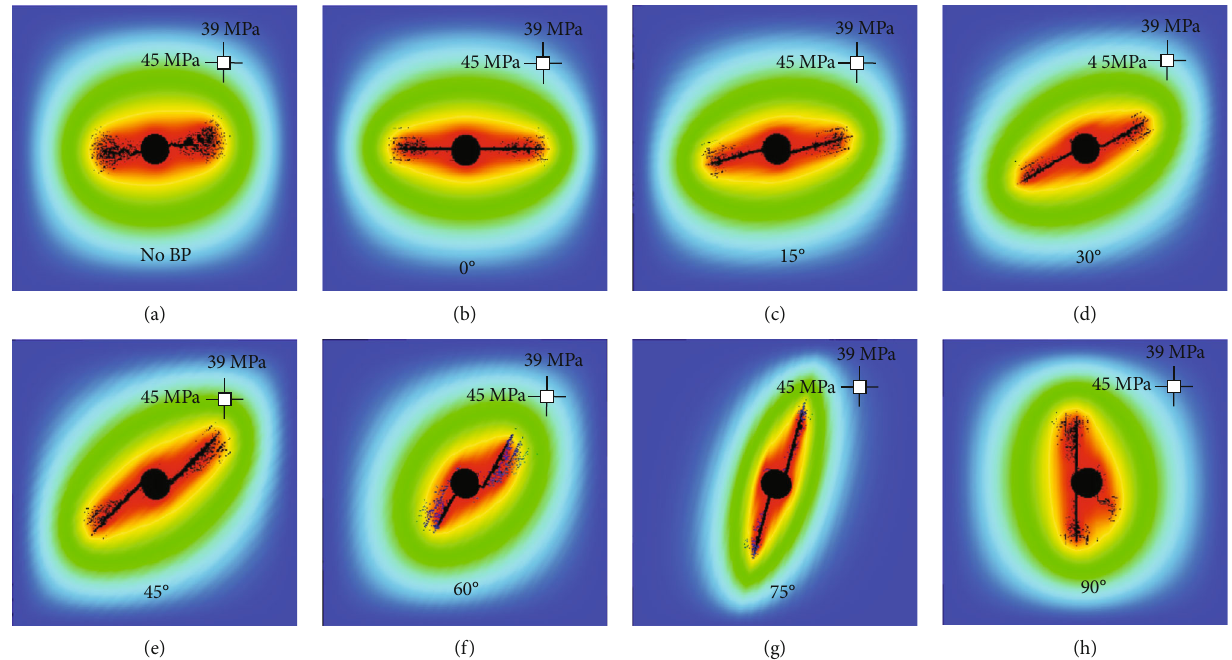
Figure 7: HF morphologies having a small permeability coe ffi cient under di ff erent BP angles with actual in situ stress ( K ′ = K ′ = 0 : 0005 m/d, where K m/d, K h v the BP).